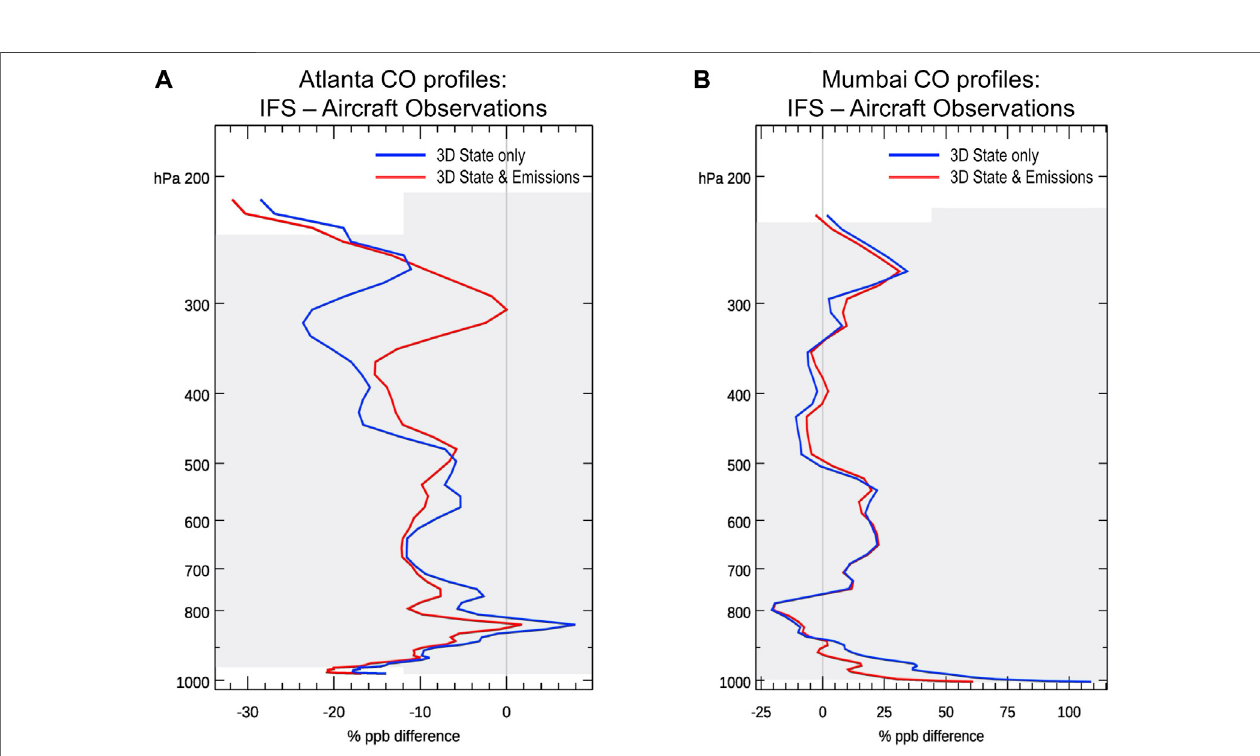
Frontiers in Remote Sensing |